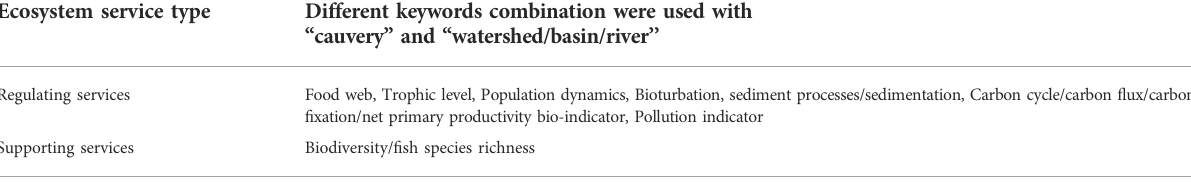
TABLE 1 Different keyword combinations for the literature search. Ecosystem service type Different keywords combination were used with “ cauvery ” and “ watershed/basin/river